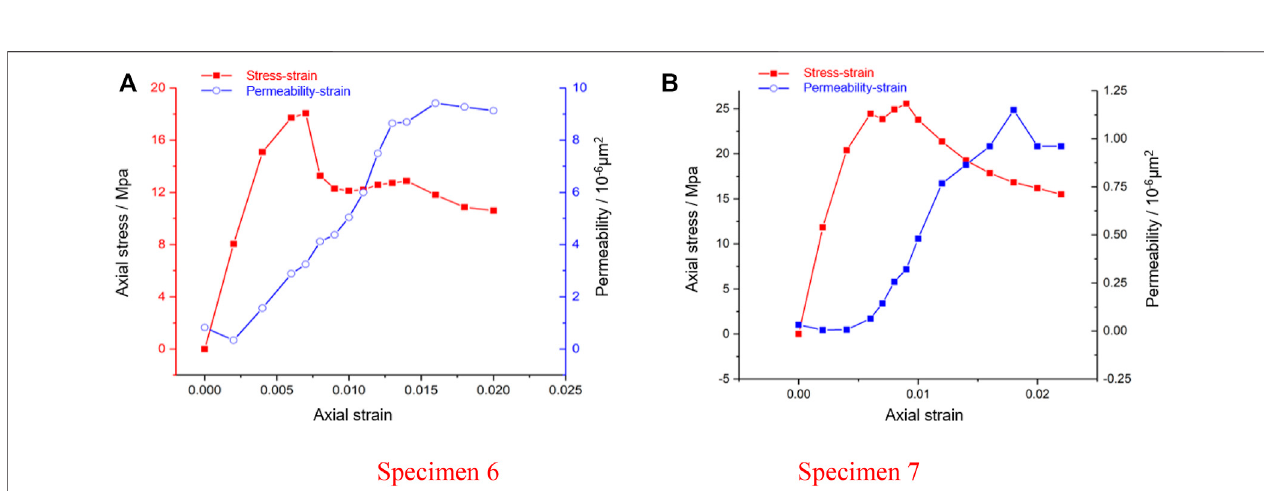
FIGURE 5 | The stress-strain-permeability curve. (A) : Specimen 6. (B) : Specimen 7.